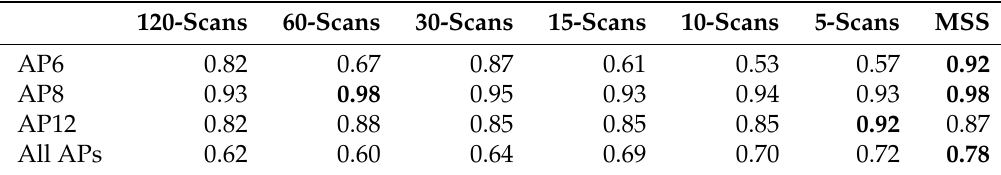
Figure 18. The performance of all APs and individual AP LOS identification using datasets of different sampling sizes, compared to MSS. Statistical features of all APs were used except for MSS where only selected features were used. Features selected by MSS are more informative than features from single sample size dataset. Table 5. The Macro F1 score performance of all APs and individual AP LOS identification using datasets of different sampling sizes, compared to